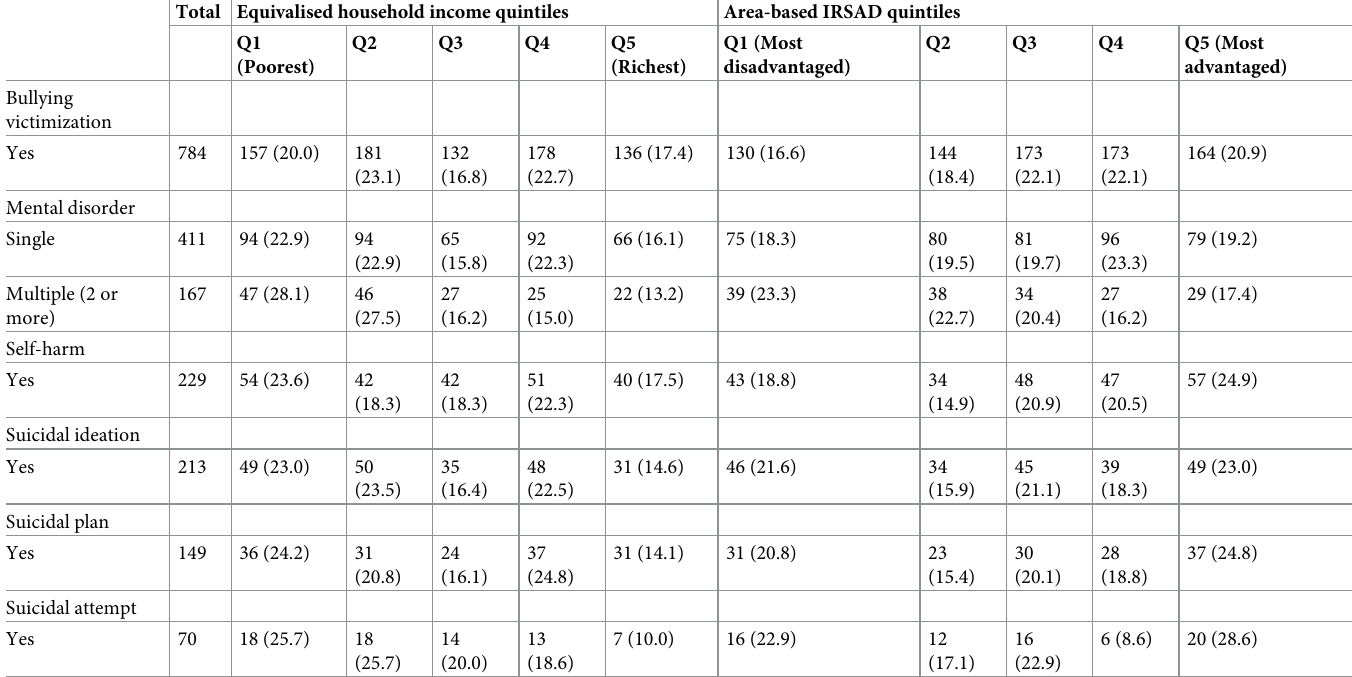
Table 2. Prevalence (%) of mental health problems by household income quintiles and area-based IRSAD quintiles. Total Equivalised household income quintiles